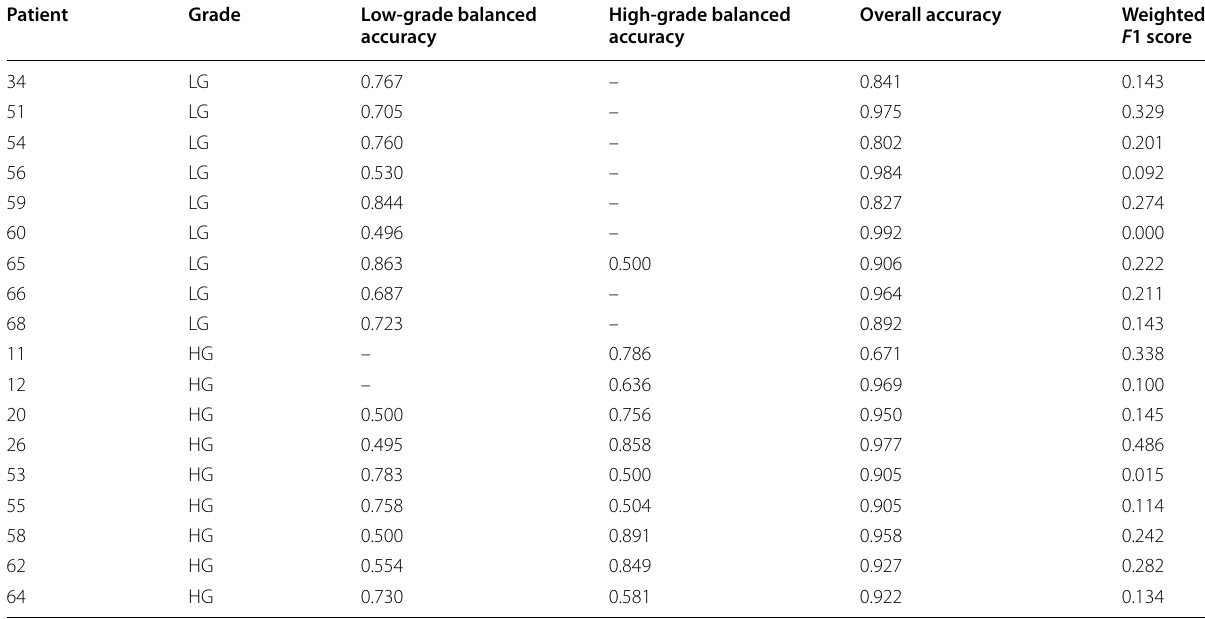
Table 5 Overall performance of tumour grading RFC model, with patients ordered according to whether they had a low-grade (LG) or high-grade (HG) index lesion